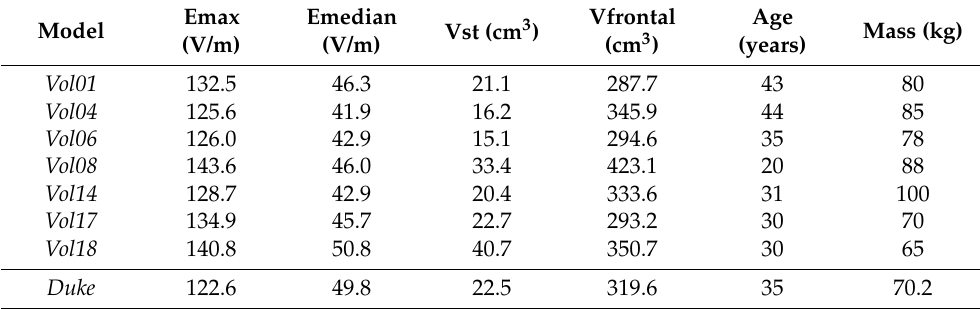
Table A3. Stimulation metrics (Emax, Emedian, and Vst) on the frontal lobe and model parameters (frontal lobe volume, age, mass) of the homogeneous male models and the homogeneous version of the Duke ViP model.